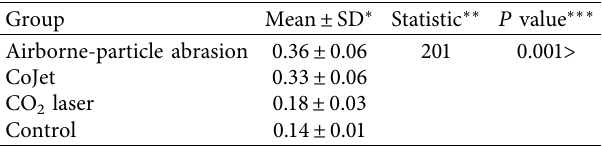
Figure 2: A ceramic bracket bonded to a zirconia disc in a universal testing machine for measurement of shear bond Table 1: Comparison of surface roughness ( µ m) of specimens subjected to different surface treatments.